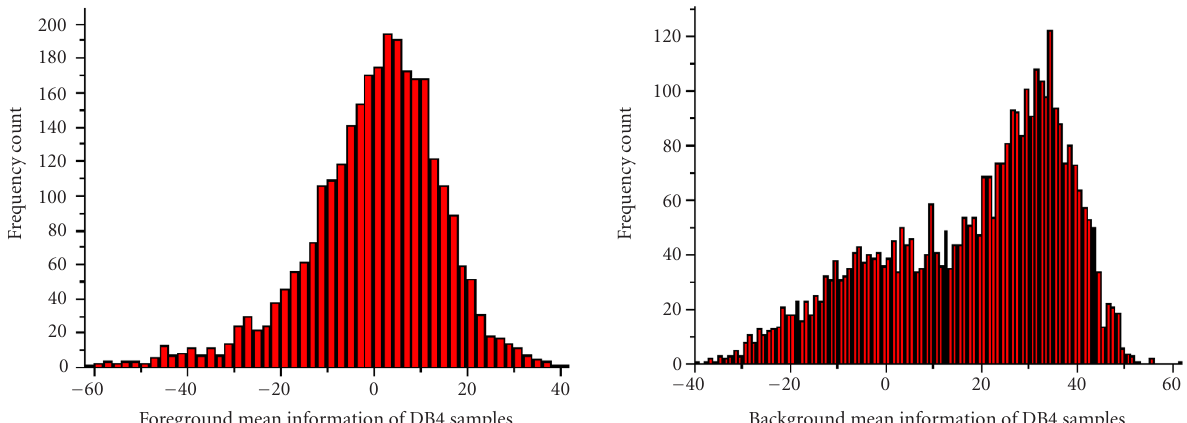
Figure 14: The block mean information MeanI of the samples. The horizontal coordinate represents the value of the block mean information while the vertical coordinate represents the frequency count of the value.